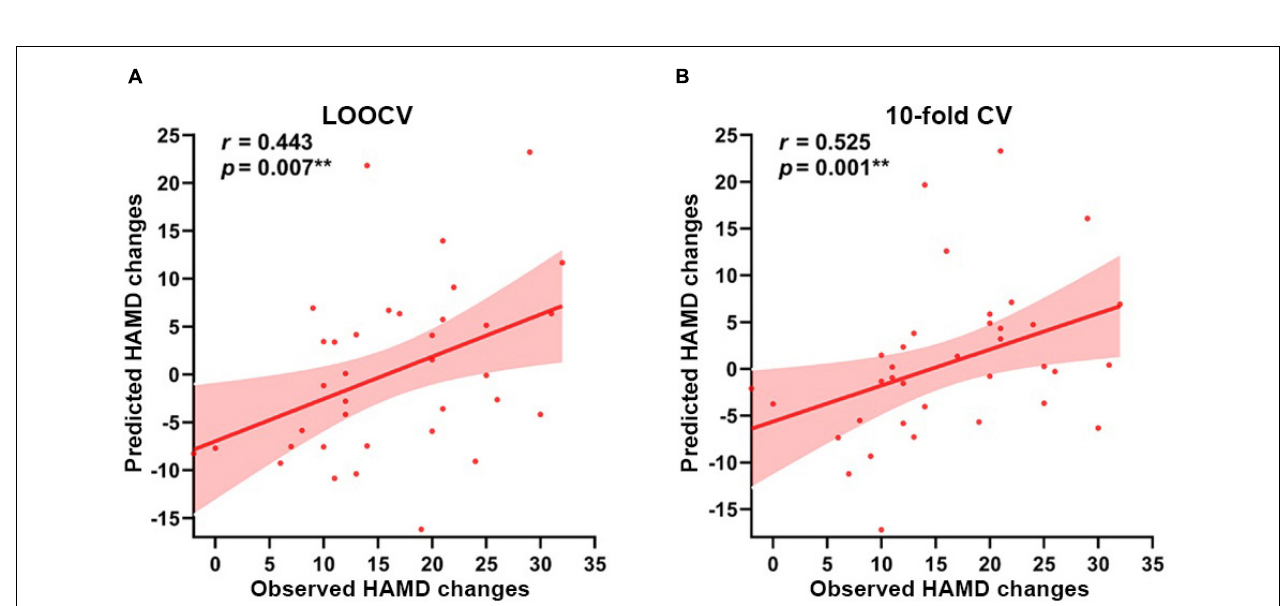
FIGURE 4 | Prediction results based on the EC of right amygdala subregions at baseline for symptom improvement. Scatter plots show the Spearman’s rank correlations between the observed HAMD scores changes and predicted HAMD scores changes of all participants in (A) LOOCV: r = 0.443, permutation p = 0.007, and (B) 10-fold CV: r = 0.525, permutation p = 0.001, respectively. ** p < 0.01. LOOCV, Leave-one-out cross-validation; 10-fold CV, 10-fold cross-validation; HAMD, 24-item Hamilton Rating Scale for